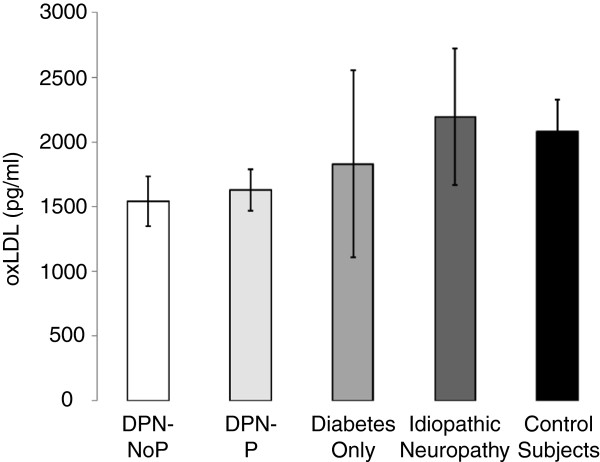
Mean plasma oxLDL levels are demonstrated for each group. There were no significant differences detected between any groups for any of the relevant comparisons. Error bars denote standard error of the mean (SEM).